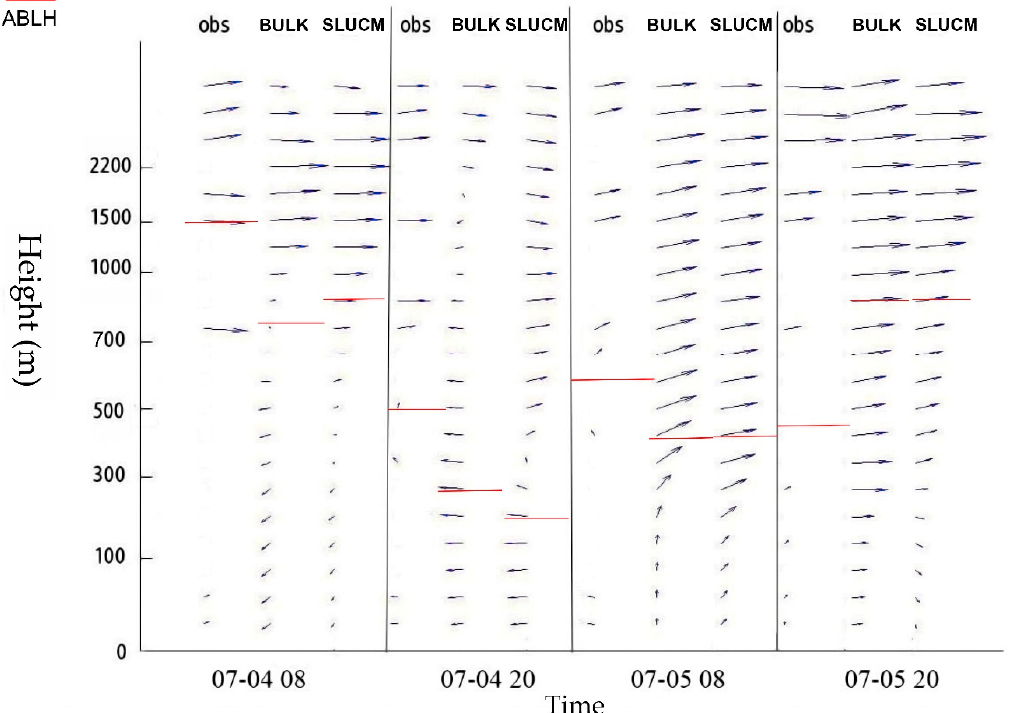
Figure 7. Vertical wind profile and ABLH measured by radio soundings and model results at station s1 at 8:00 and 20:00 on 4 July and 5 July 2011.